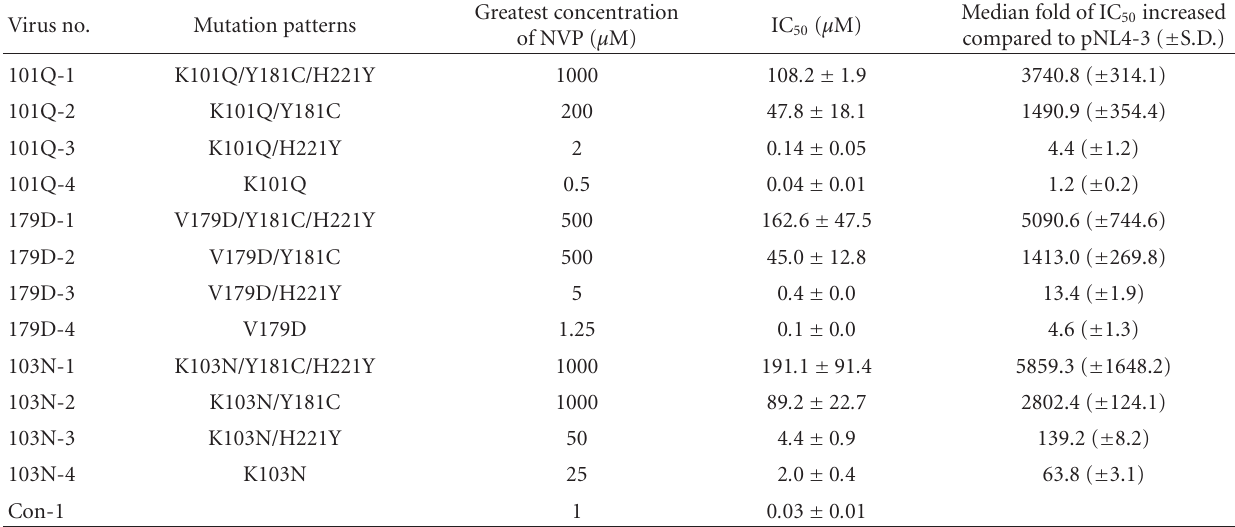
Table 1: The greatest initial NVP concentrations of every virus, IC 50 ( μ M) of every virus and the increased NVP resistance compared to pNL4-3.